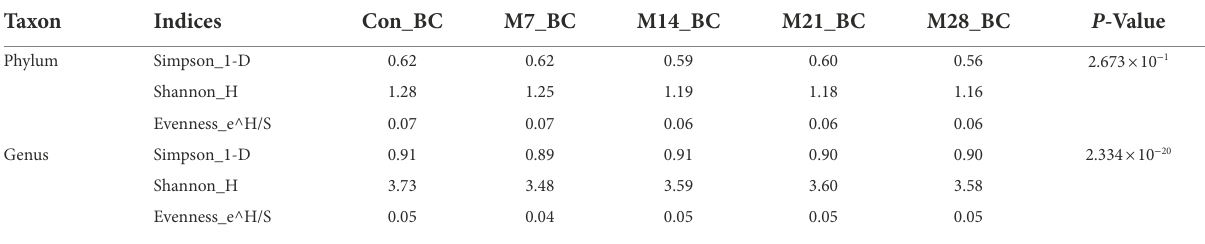
TABLE 3 The estimation of alpha diversity indices of microbial communities in caecum digesta samples from broiler chickens fed with diets containing different levels of marama bean meal.